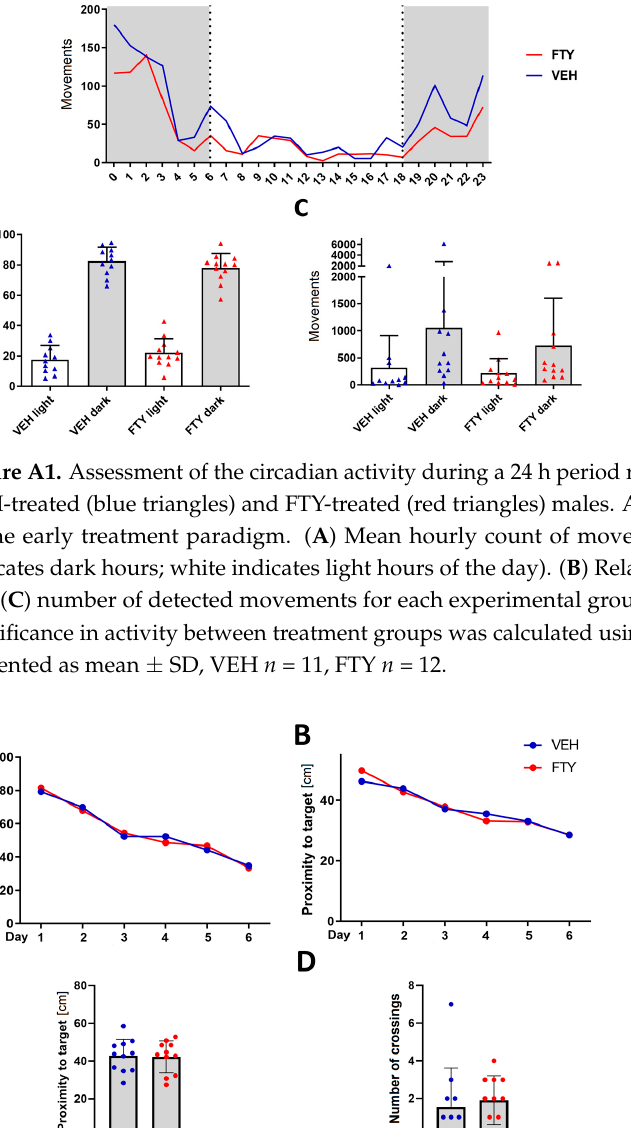
Figure A2. Spatial orientation testing using water maze revealed no significant differences between VEH-treated (blue circles) and FTY-treated (red circles) females. Animals were treated according to the early treatment paradigm. ( A ) Time latency [s] average of each experimental group to find the platform during training trials. ( B ) Proximity average [cm] during training. ( C ) Proximity to target and ( D ) number of target crossings ( n ∈ N) during the probe trial. Significance between treatment groups was calculated using the Student’s t -test ( C ) or Wilcoxon–Mann–Whitney test ( D ). Data are presented as mean ( A , B ) and mean ± SD ( C , D ), VEH n = 11, and FTY n =